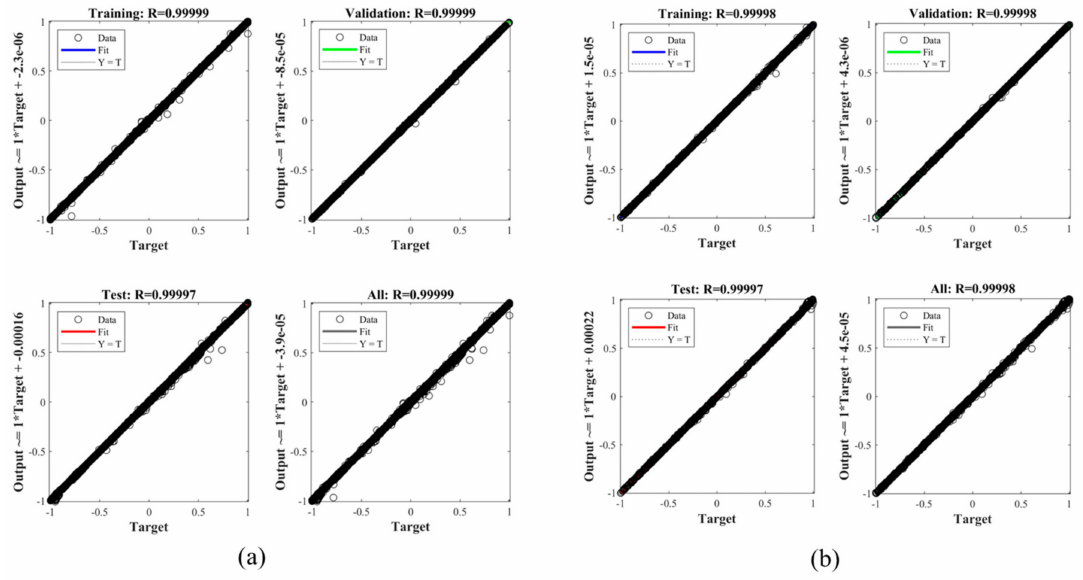
Figure 10. Correlation analysis of the model: ( a ) R2 of the x- and y-axis; ( b ) R2 of the z-axis. The model residual is the difference between the predicted value and the actual value. From Figure 11a, it can be found that the residuals of measuring point four and measuring point eight are the largest in the x- and y-axis, though the maximum residual is <2.5 × 10 − 8 m, which is within the acceptable range; in Figure 11b, the residual of measuring point 13 is almost zero, which means that the predicted value of measuring point 13 is the most accurate, and the residual of measuring point four is larger, with a value range of ( − 0.04 m–0.03 m), which is also within the acceptable range.